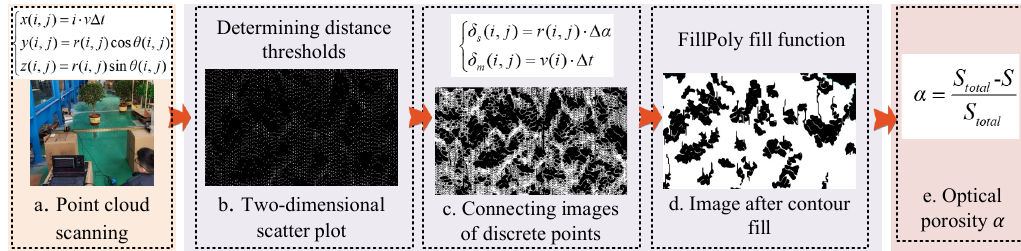
Figure 1. Flowchart for calculating optical porosity.